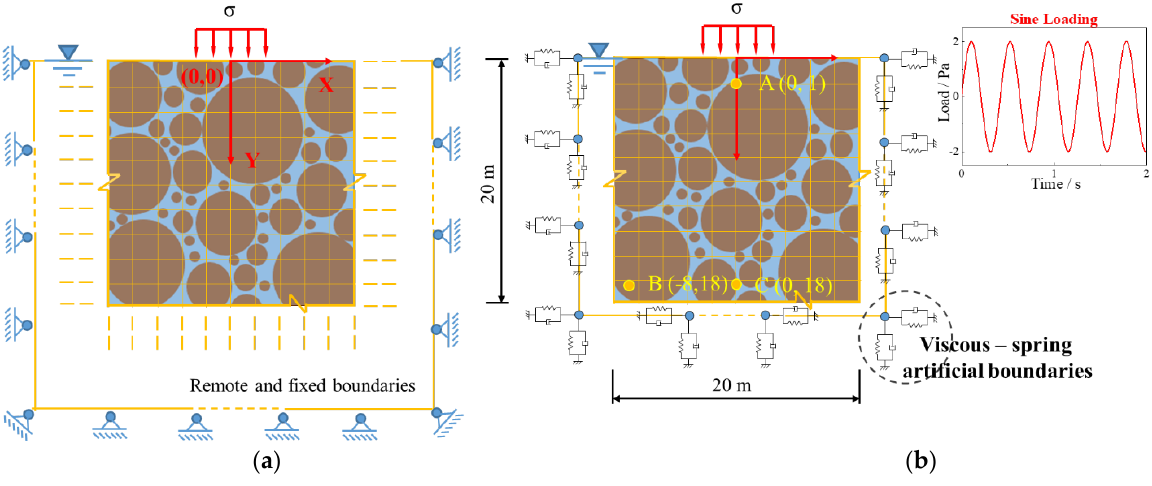
Figure 4. Two-dimensional saturated soil model under sine loading: ( a ) Model with remote and fixed boundaries; ( b ) Model with viscous – spring boundaries.